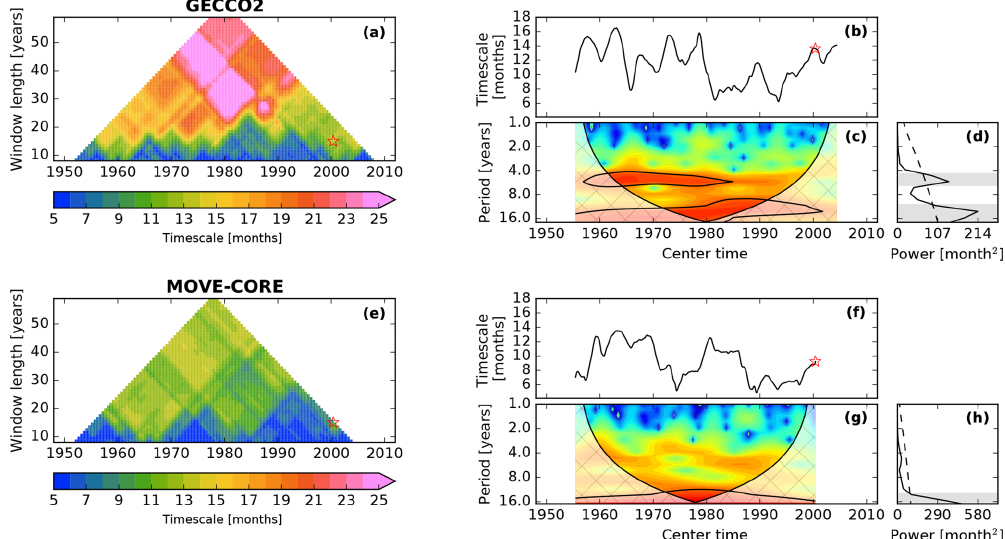
Figure 7. (a) Moving e -folding timescales estimated for the ice volume anomaly time series from the GECCO reanalysis. The window length varies from 5 to 59 years, and it is stepped forward by 1 month over a total period of 64 years (January 1948–December 2011). (b) Moving e -folding timescales for the 15-year window length case. The red stars in (a) and (b) indicate the 15-year overlapping period (January 1993– December 2007, center time mid-June 2000). (c) Wavelet power spectrum of (b) , with Morlet as the mother wavelet. The black lines denote the 95% significance levels above a red noise background spectrum, while the crosshatched areas indicate the cone of influence, in which the edge effects become important. The color bar is omitted in panel (c) since we are not interested in the power’s magnitude but in the frequencies outstanding as significant in the spectrum. (d) Time-integrated power spectrum from the wavelet analysis, where the dashed line corresponds to the 95% significance level. The bands of significant periods (4.4–6.1 years and > 10 . 7 years) are highlighted by the gray horizontal bars. (e) – (h) Same as (a) – (d) , respectively, but for the MOVE-CORE ice volume anomaly which has a spanning period of 60 years (January 1948–December 2007). The horizontal gray bar in (h) highlights the only period band of significant variability, defined by periods longer than 12.7